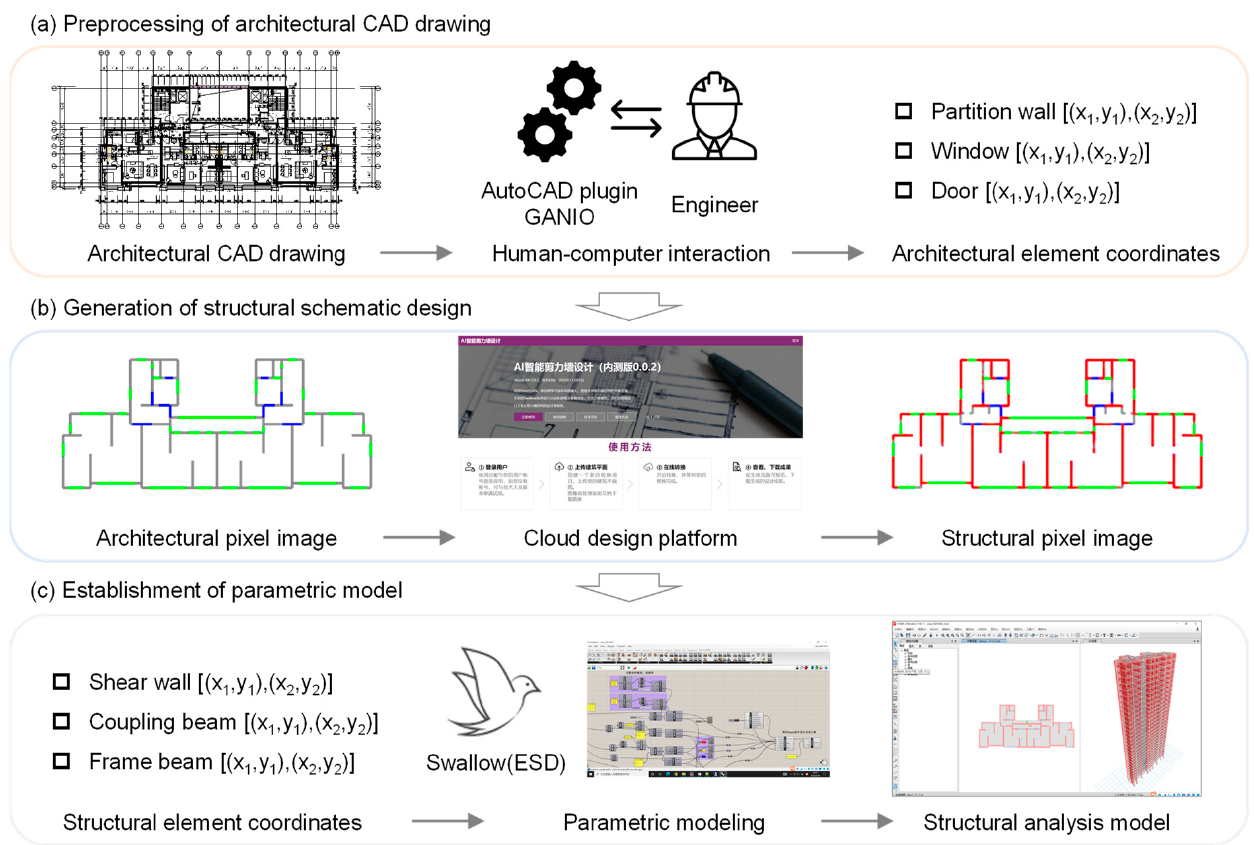
Figure 2. Key modules of the proposed integrated schematic design method.